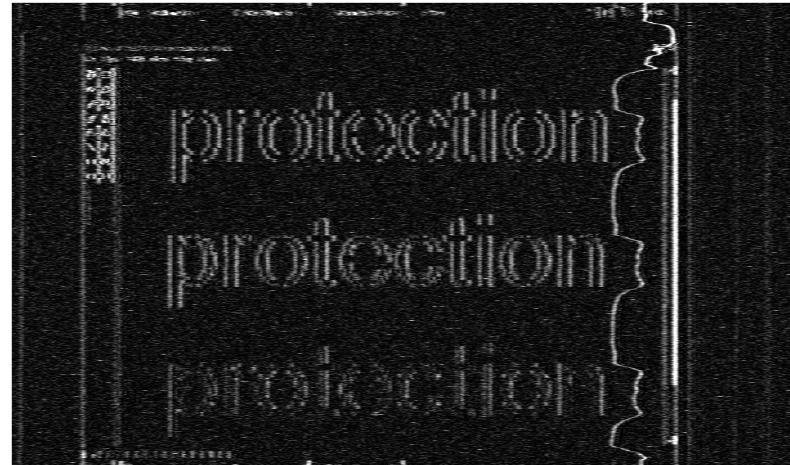
Figure 18. An example of an image obtained based on compromising emanations measured in the frequency f o = 494 MHz ( BW = 10 MHz, sampling frequency f s = 1250 MHz) for a source of emission in analogue VGA standard form.